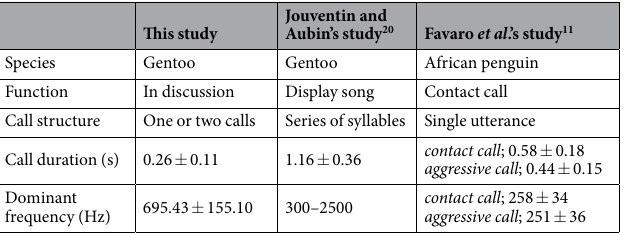
Table 3. Comparison of the acoustic characteristics of penguin calls in this study and the two previous studies.